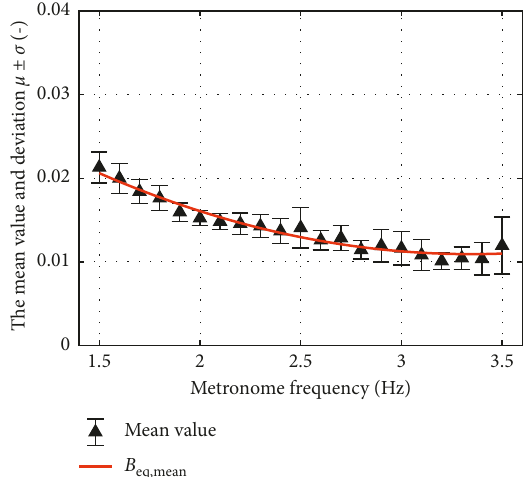
Figure 11: Summary of mean values and standard deviations of equivalent bandwidth for the reference